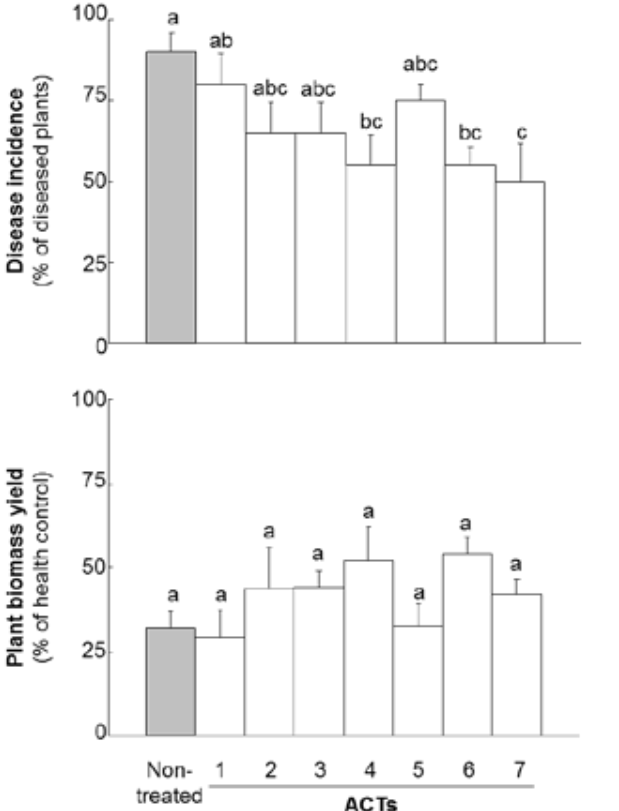
Figure 3. Mean disease incidence and mean plant biomass (±1 SE) for savoy cabbage plants drenched with different aerated compost teas (ACTs), growing in media inoculated with Rhizoctonia solani. Different letters indicate significant differences ( P ≤0.05) according to Duncan’s test.